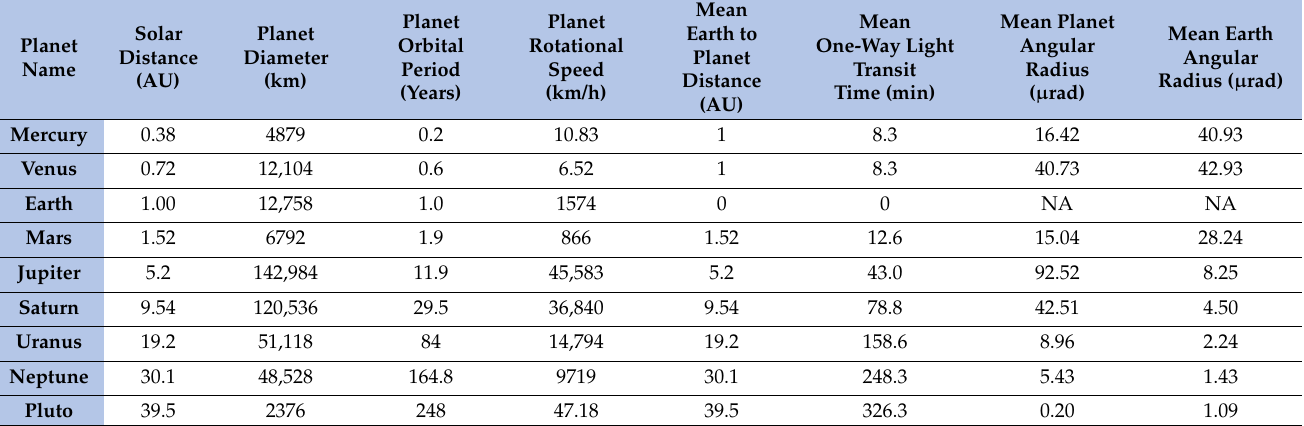
Table 1. Planetary parameters relevant to the acquisition and tracking of the opposite terminal during wideband communications between Earth and the planet under investigation. The angular radii for Earth and the planet it is communicating with corresponds to the angular spread seen by the opposite terminal at the average interplanetary distance. The actual distance can vary between RPE ave +/ − 1